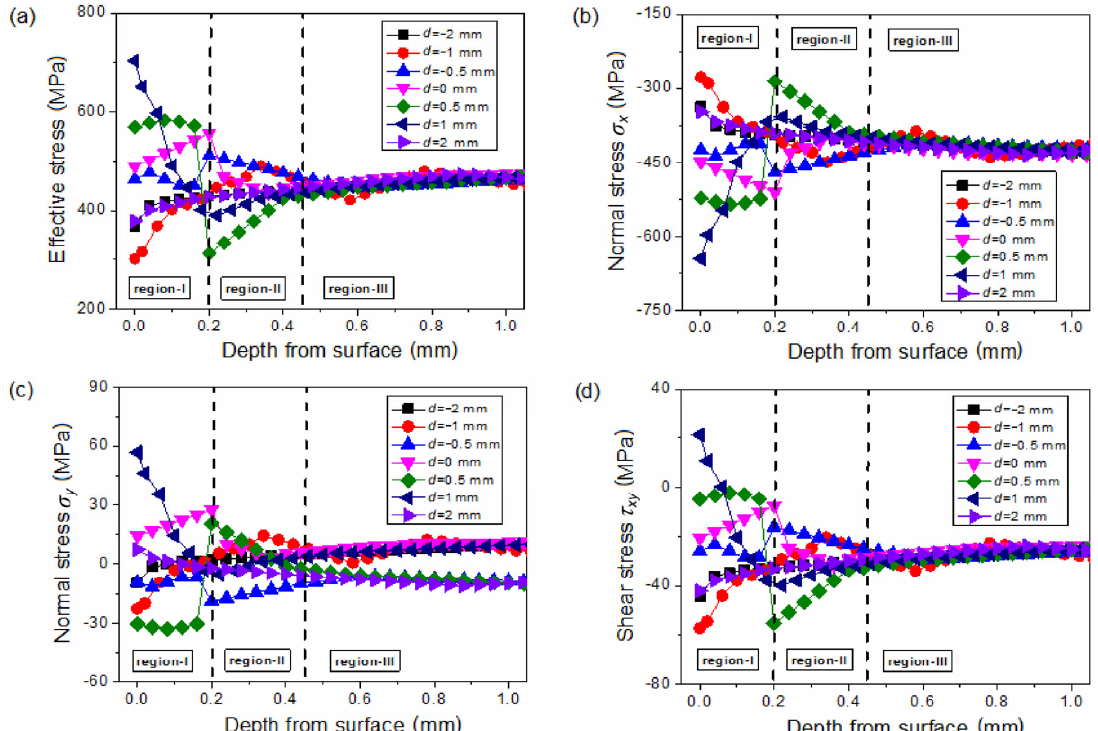
Fig. 6 Residual stress distribution along the rail depth at seven selected positions around the WEL: (a) residual effective stress, (b)  , (c) residual normal stress residual normal stress x